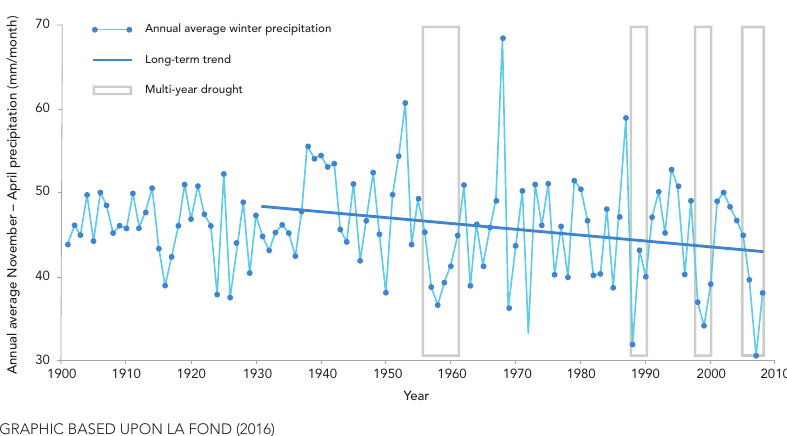
Figure 1. Rainfall (1901–2008): Precipitation patterns are changing in the Fertile Crescent. Rainfall from November through April, when most of it occurs, has decreased 13% since 1931. The gray boxes represent multi-year droughts, which are defined as three or more consecutive years when precipitation is below the century-long average. This unusually severe drought directly preceded Syria’s Arab Spring uprising (in early 2011). The severity and duration of the drought caused an agricultural collapse and a subsequent mass migration of farmers and their families to the urban areas in Syria’s west. The influx of internally displaced people into the cities after the prior arrival of Iraqi refugees and on top of robust natural population growth, led to overcrowding, a lack of employment and resources, a sharp increase in crime in the urban peripheries and, perhaps most importantly, little or no relief from the government. The Syria conflict escalated into a prolonged and bloody civil war that led to Syrians fleeing the country for their safety and causing a global refugee